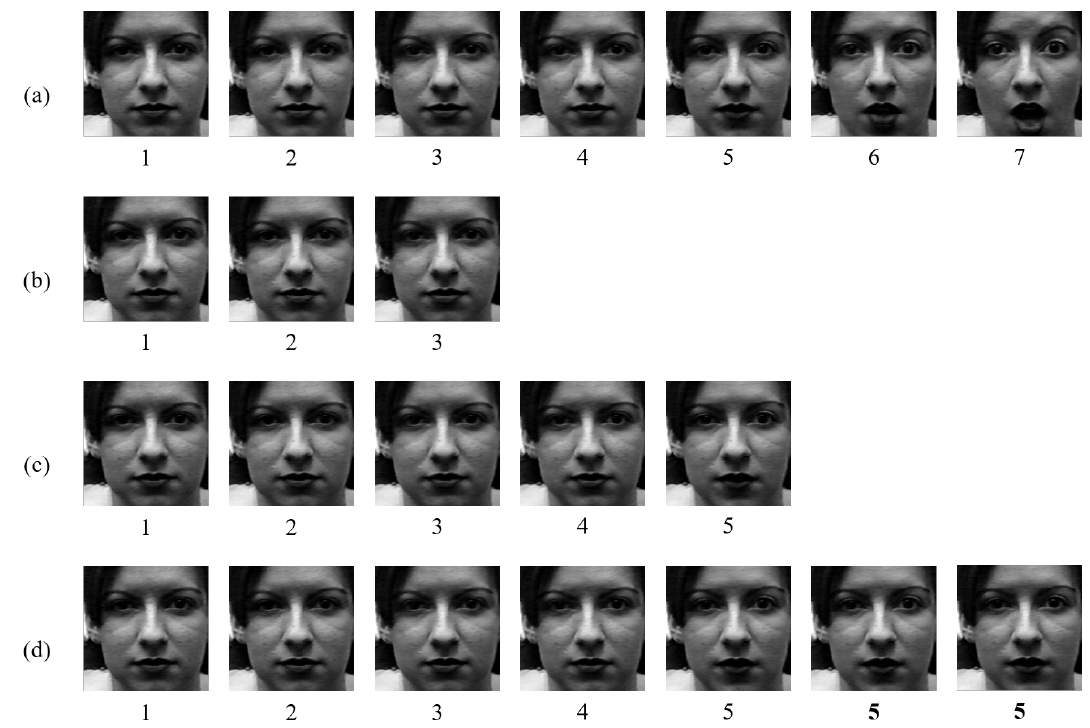
Figure 13. The examples of the neutral labeled frames: ( a ) seven consecutive frames; ( b ) neutral frames for three; ( c ) neutral frames for five; and ( d ) neutral frames for seven.